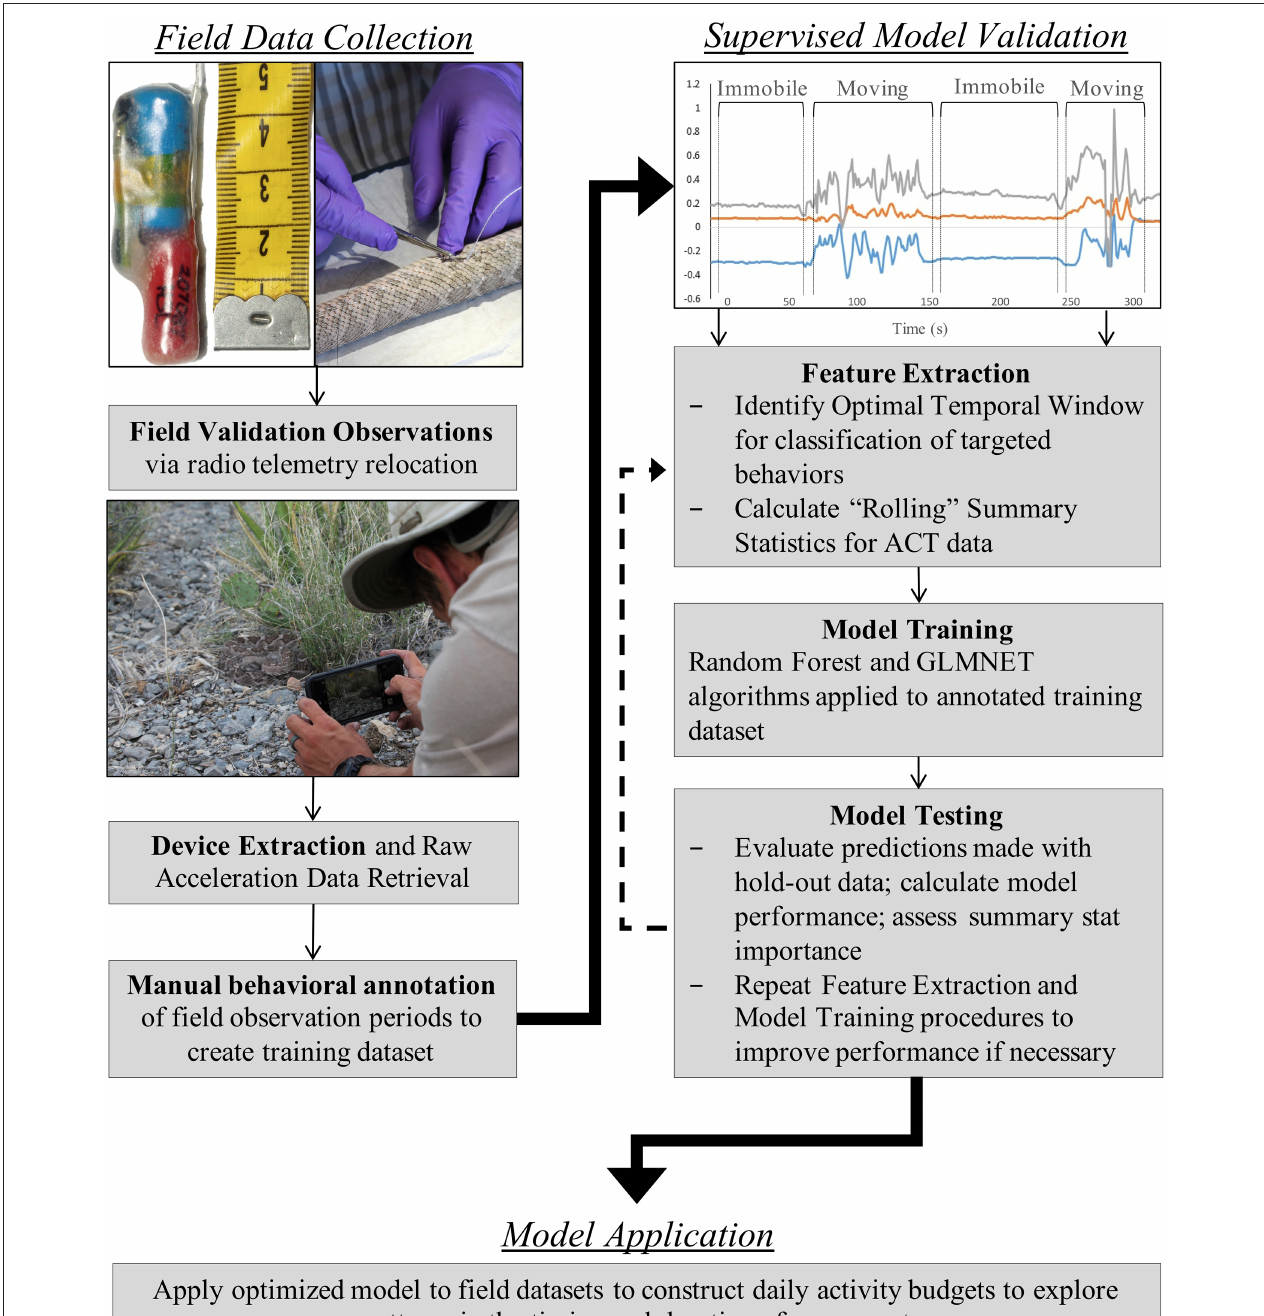
FIGURE 1 | Stepwise ( Field Data Collection, Supervised Model Validation, Model Application ) RT-ACT methodological framework for long-term, low-frequency accelerometer (ACT) data collection, processing, and analysis procedures validated herein. Details regarding each step in the framework can be found within methods